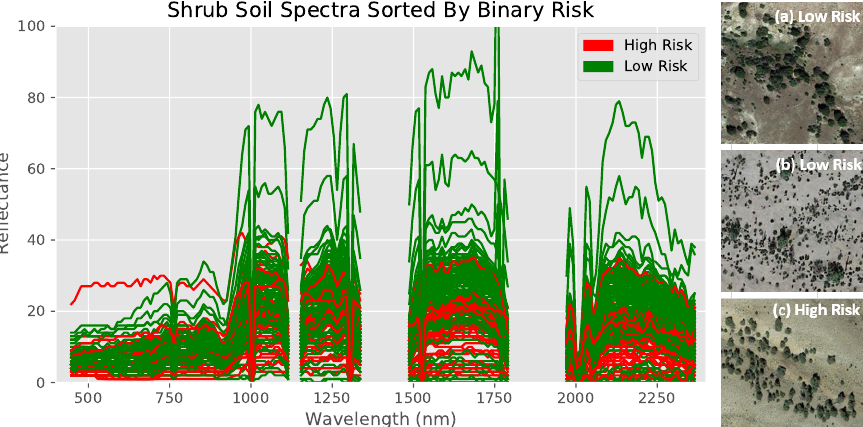
Figure 6. Comparing reflectance spectra of locations with differing arsenic concentrations but similar soil composition and visual satellite appearance for shrubland. Sites have similar soil risk and visual satellite appearance, as shown on the right. Overall, some differences can be seen, but they are not as visibly distinct as with bare